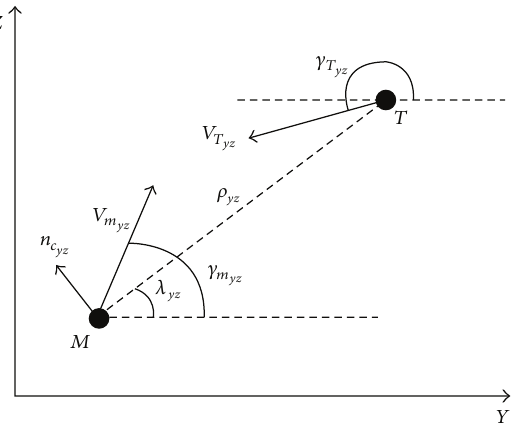
Figure 6: Relative kinematics on 𝑆 𝑦𝑧